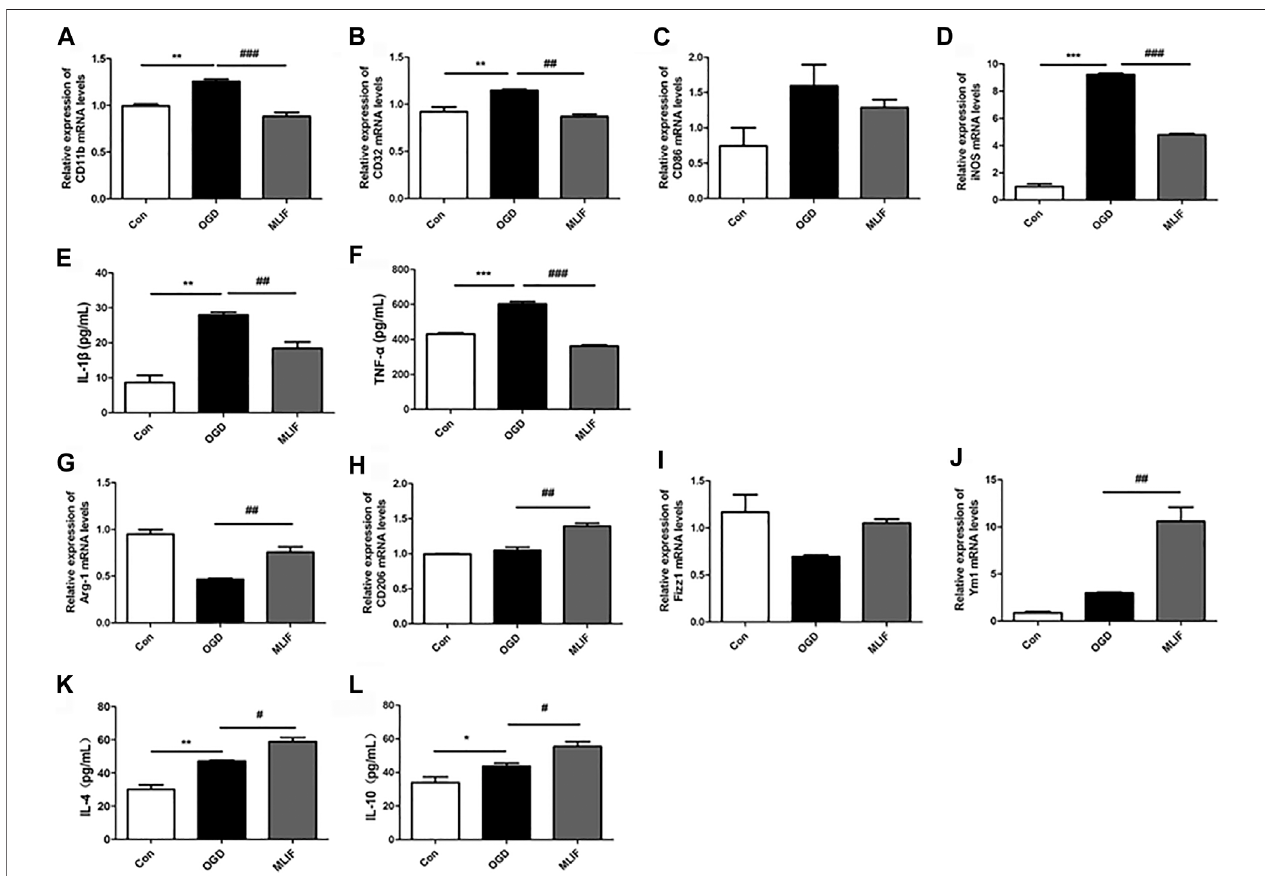
FIGURE 2 | MLIF promoted microglia polarization toward M2 polarization in OGD-insulted BV2 microglia. BV2 cells were exposed to OGD for 4 h with or without MLIF(1.0 μ g/ml)incubation.Real-timePCRwasusedtodetecttheM1signaturegenesCD11b (A) ,CD32 (B) ,CD86 (C) ,andiNOS (D) andtheM2signaturegenesArg- 1 (G) ,CD206 (H) ,Ym1 (I) ,and Fizz1 (J) . ELISAwasused todetectM1-related in fl ammation cytokinesIL-1 β (E) and TNF- α (F) and M2-related cytokinesIL-4 (K) and IL- 10 (L) in the cell supernatant. Data are expressed as the mean ± SEM. N (cid:1) 3. * p < 0.05, ** p < 0.01, *** p < 0.001, vs Control group; # p < 0.05, ## p < 0.01, ### p < 0.001, vs OGD